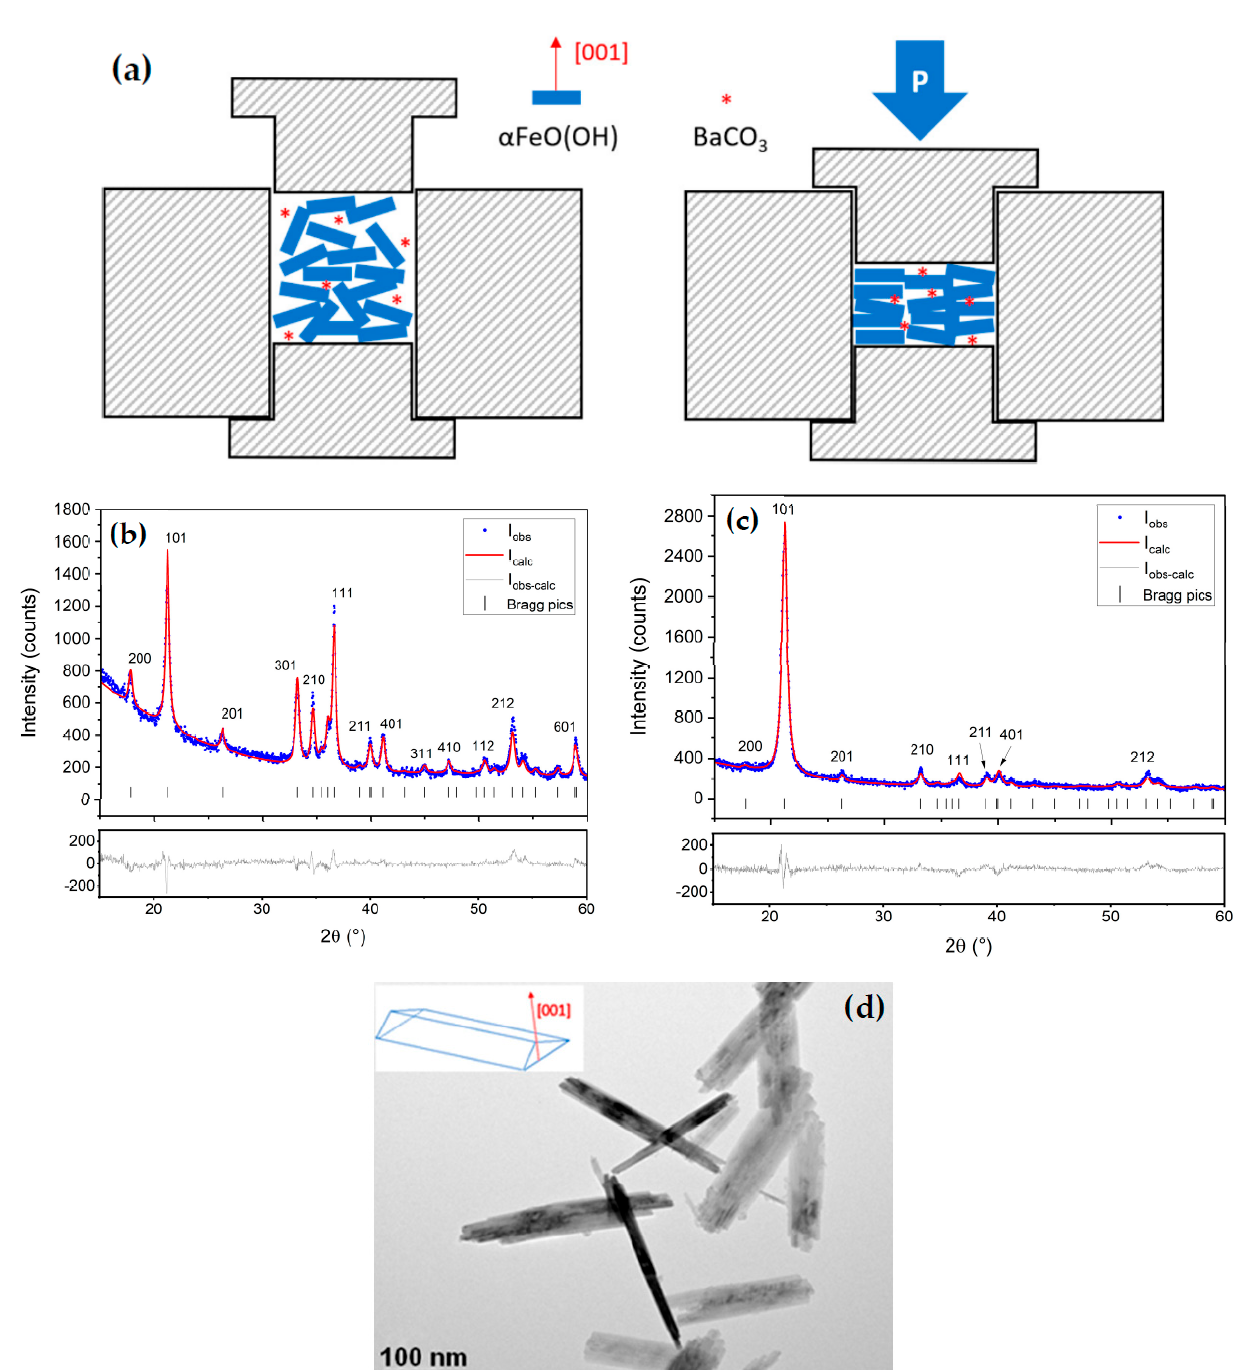
Figure 1. ( a ) Schematic representation of the alignment in the basal plane of goethite crystallites, observed after uniaxial pressure. ( b , c ) Rietveld analysis of goethite before and after pressing process, respectively. ( d ) TEM images of lath ‐ shaped goethite crystallites.